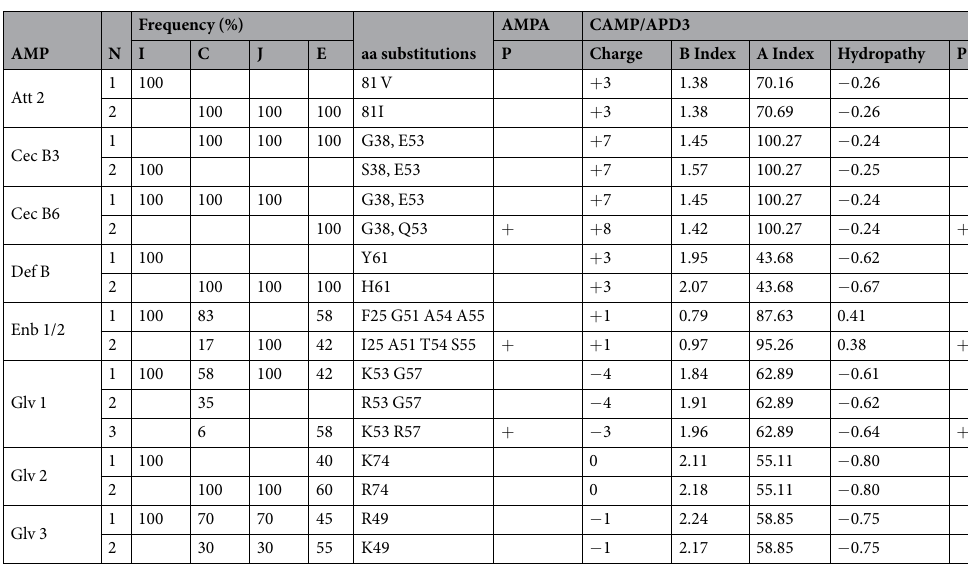
Table 3. Antimicrobial activity prediction of the mature AMP isoforms detected in the four B . mori strains. Frequency (%): frequencies of the isoforms in the four strains (I: Indian, C: Chinese, J: Japanese, E: European); AMPA: output of the AMPA tool; CAMP/APD3: output of the CAMP/APD3 tools; Charge: net charge; B Index: Boman index; A Index: Aliphatic Index; P: antimicrobial prediction; + : indicates for each AMP the isoform with the highest predicted antimicrobial